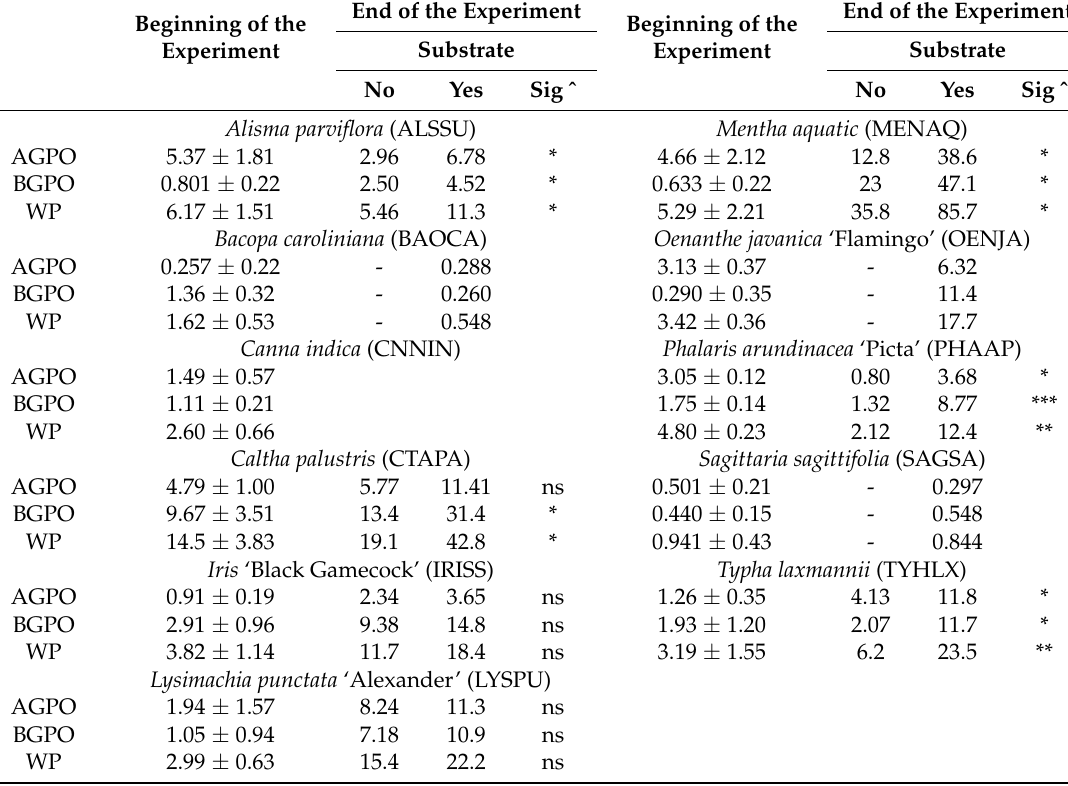
Table 1. Dry weight of above-ground plant organs (AGPO), below-ground plant organs (BGPO), and whole plant (WP) at the beginning and at the end of the experiment (g plant − 1 ± sd). End of the Experiment End of the Experiment Beginning of the Beginning of the Substrate Substrate Experiment Experiment No